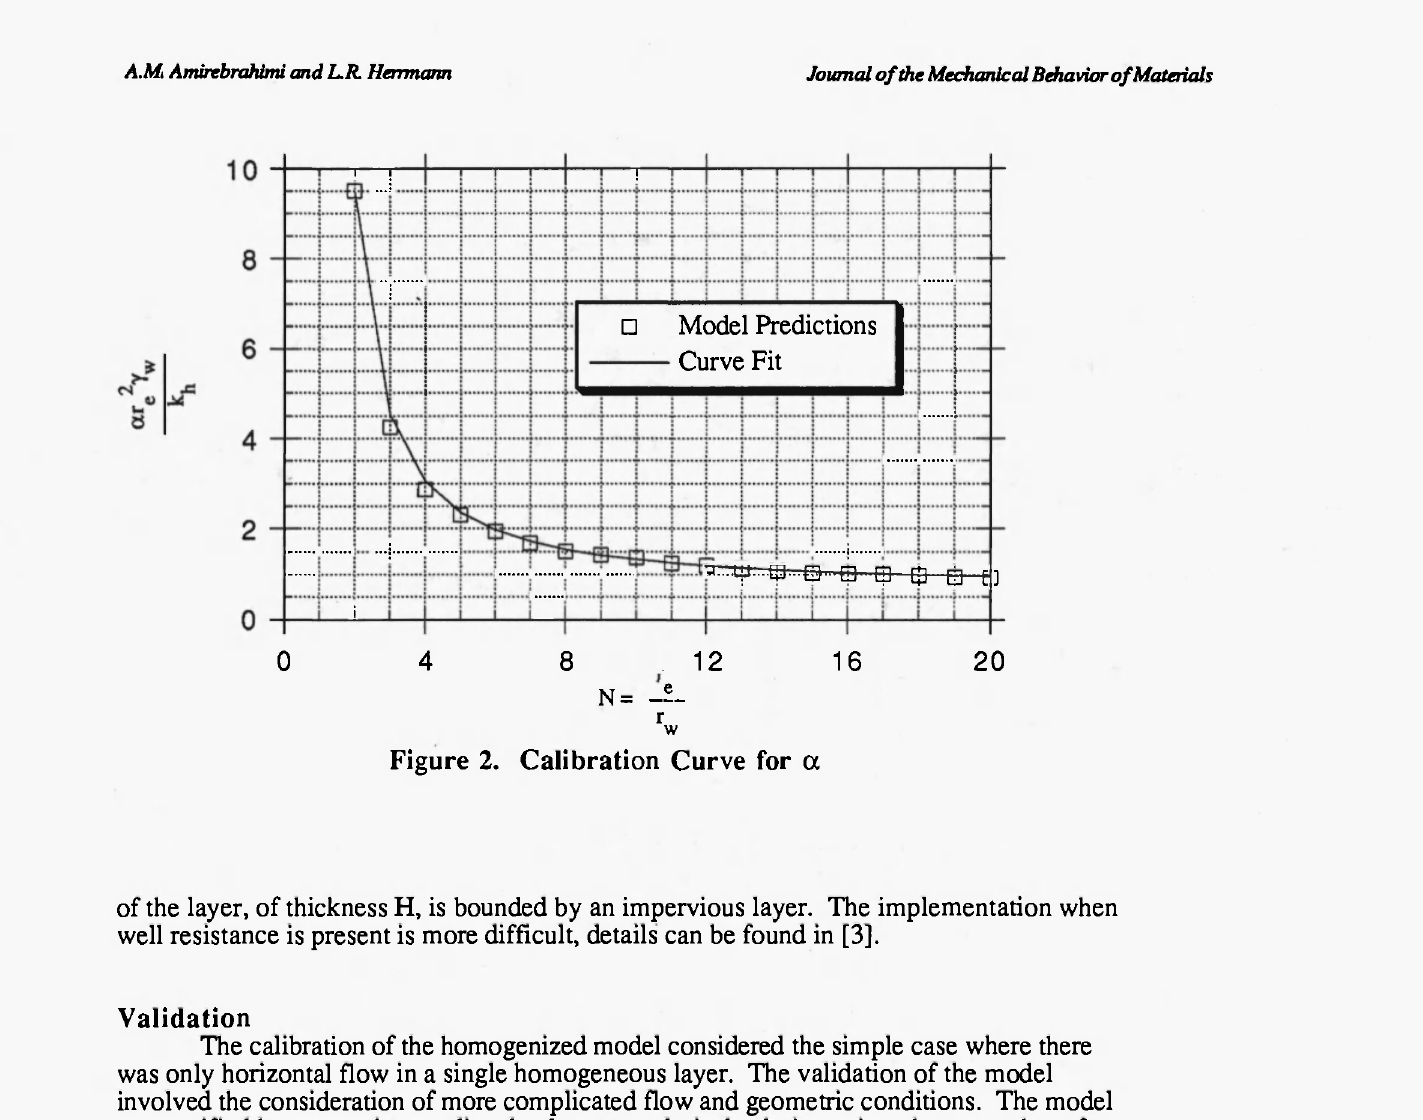
Figure 2. Calibration Curve for